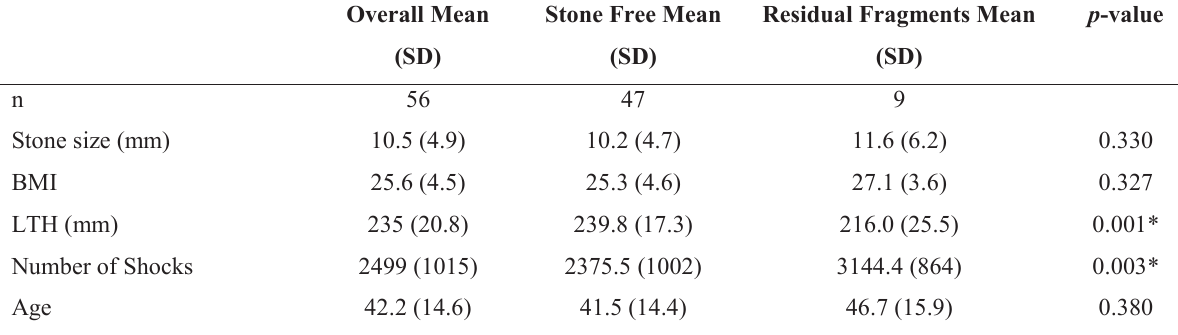
Table 1. Clinical and demographic characteristics. Table 1 - Clinical and demographic